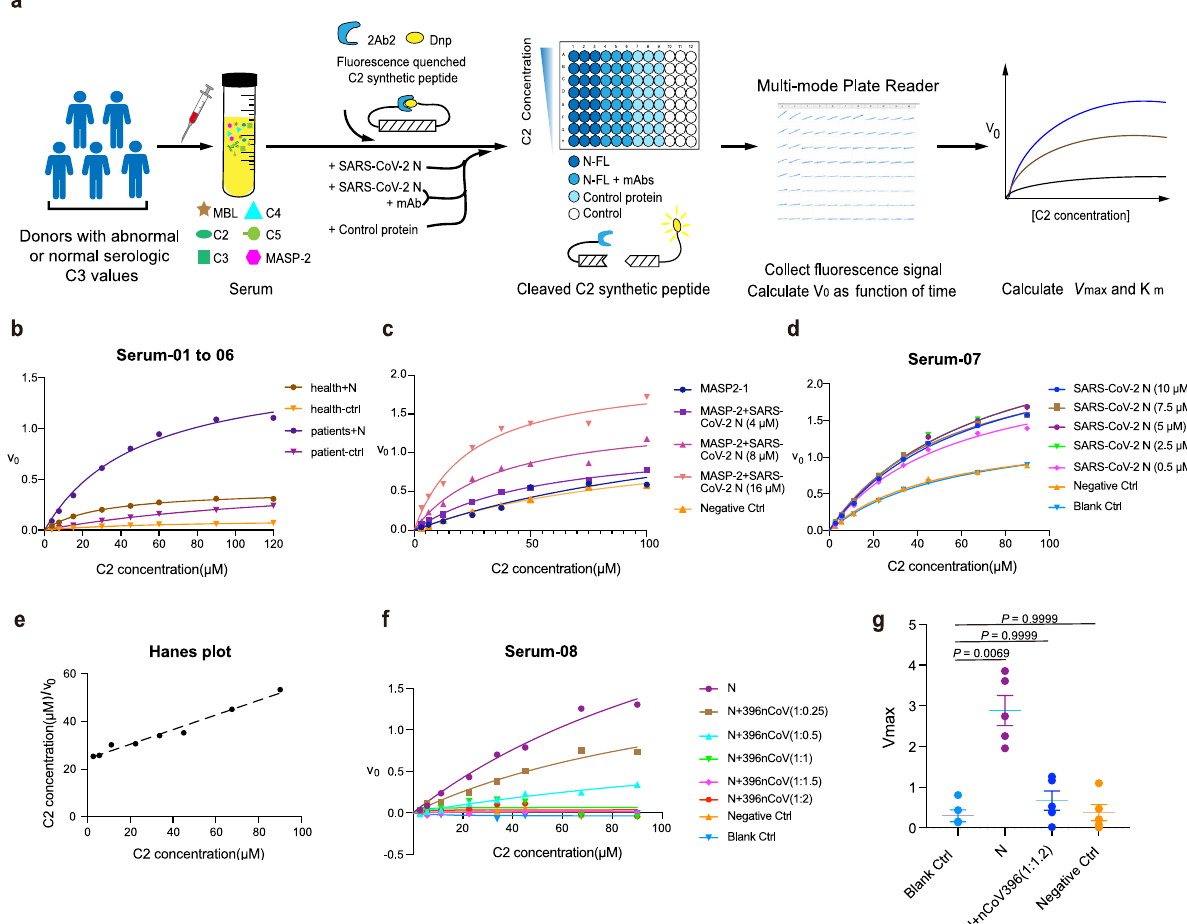
Fig. 4 Antibody nCoV396 compromises SARS-CoV-2 N protein-induced complement hyperactivation. a Flow scheme of the SARS-CoV-2 N protein and nCoV396 in fl uencing the protease activity of MASP-2 in the serum from donors. b Serum-01 to 06 are used to compare the MASP-2 activity to C2 of serum sample with normal C3 (Health-110,113,117, n = 3) and serum sample with abnormal C3 (Patient-81,123,130, n = 3), and the Michaelis – Menten curves of are presented as mean (three groups of above health serum alone with patient ’ s serum paired data are shown in Supplementary Fig. 8a). c The Michaelis – Menten curve of N protein-induced excessive cleavage of C2 in the presence of recombinant MASP-2 in vitro. The reaction system without N protein, the increase of N protein concentration and negative control protein (ENL) expressed in E. coli are presenting. The Michaelis – Menten curve shows the effect of increasing the N protein concentration ( d ) and antibody concentration ( f ) on the substrate C2 cleavage of MAPS-2 in the Serum-07 and Serum-08. e A Hanes plot where C2 concentration/V0 is plotted against C2 concentration with the addition of 5 μ M N protein. b – d , f All samples were performed in triplicates and mean were presented. g Five serum sample from biologically independent donors ( n = 5) with abnormal serologic C3 values. (Serum-08 to − 12). And we used Michaelis – Menten equation to calculate the V max (with experimental data from Fig. 4f (Serum-08), Supplementary Fig. 5b (Serum-09 to − 11), and Supplementary Fig. 7a (Serum-12)). Each sample was performed in triplicates and mean values± SEM of V max are presented. Two-sided Kruskal – Wallis test with Dunnett ’ s multiple comparisons test was used for comparing the V max of groups. The signi fi cant reference is